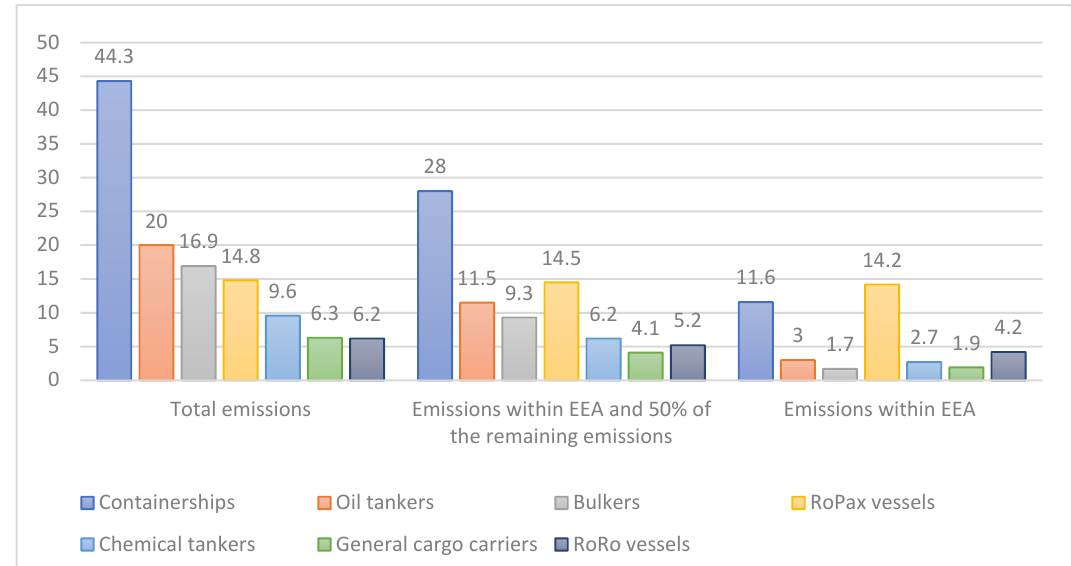
Figure 1. CO 2 emissions per maritime segment (Mtonnes). Source: Created by the authors.